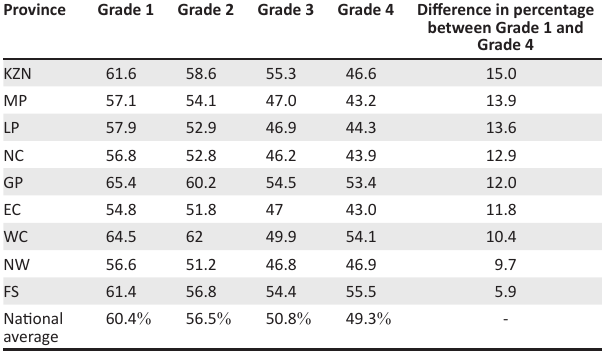
TABLE 1: Language achievement.